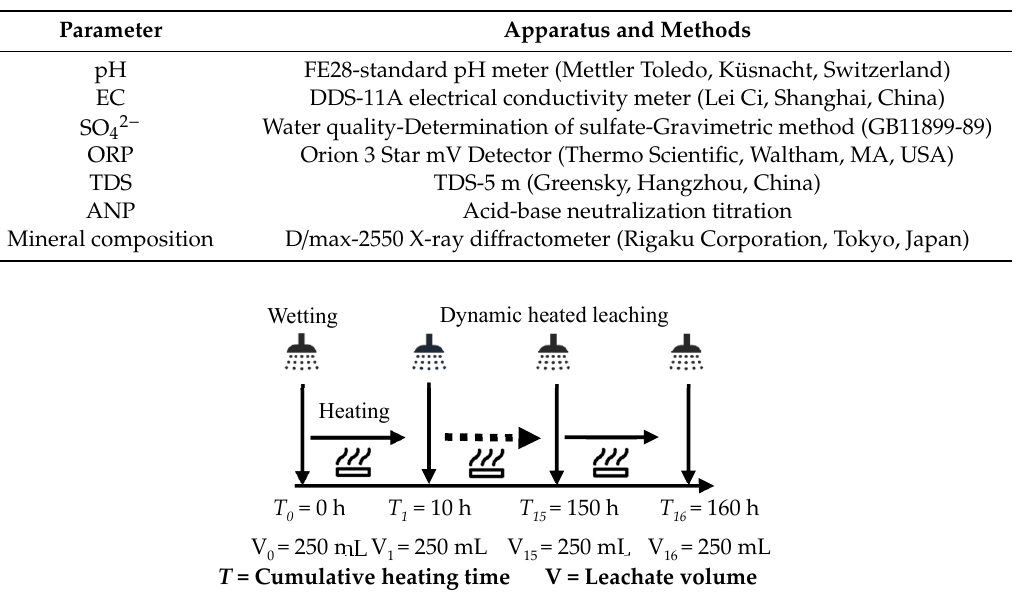
Figure 2. Schematic diagram of dynamic heating and leaching process.